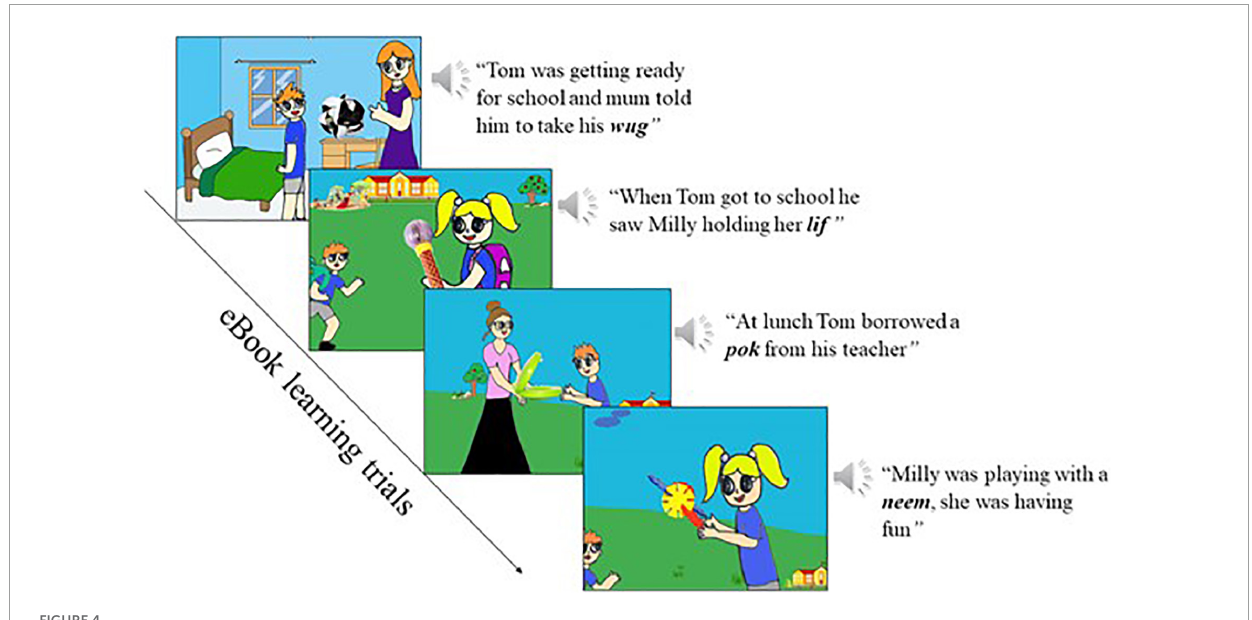
FIGURE4 Illustration of eBook